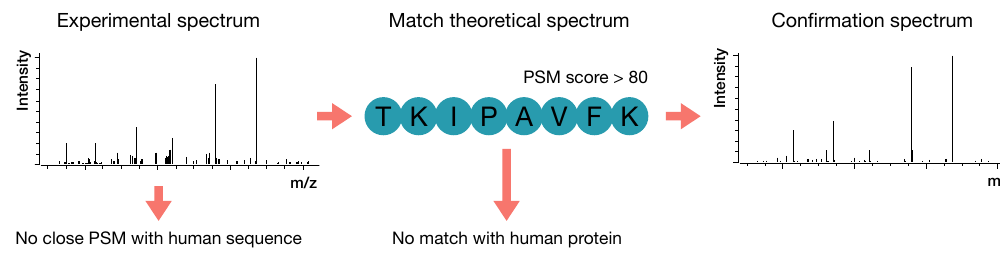
Figure 1. Schematic overview of the workflow used for confirmation of the identified nonhuman peptide sequences. After LC-MS/MS analysis, experimental MSMS spectra that matched theoretical nonhuman peptide sequences were selected when there was no close peptide sequence match (PSM) with a human peptide sequence. Spectra with a PSM score < 80 or a full match with the human proteome were removed. The final remaining spectra were confirmed with retention time and MSMS spectra of bovine milk, pure proteins, or synthetically acquired